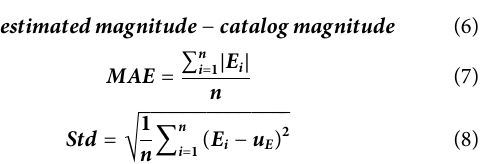
Table 1, the MAE and Std of the magnitude estimation errors for the TLDCNN-M model are 0.33 and 0.45, respectively, which are